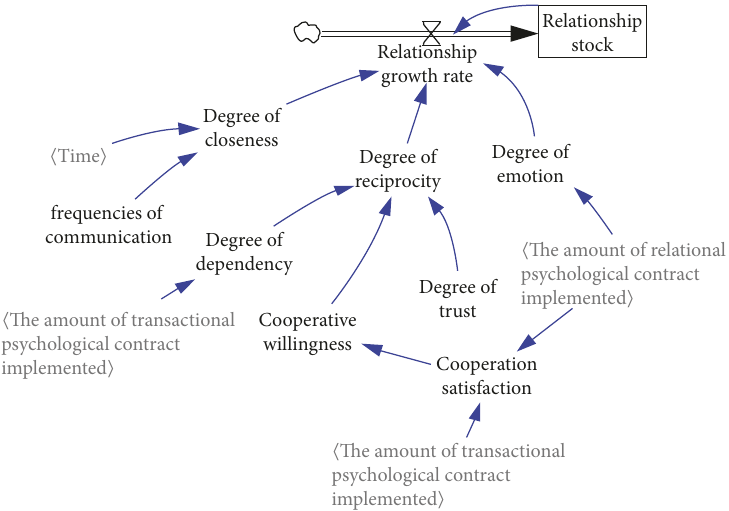
Figure 2: Relationship growth rate (RGR) rate variable in-tree branch.